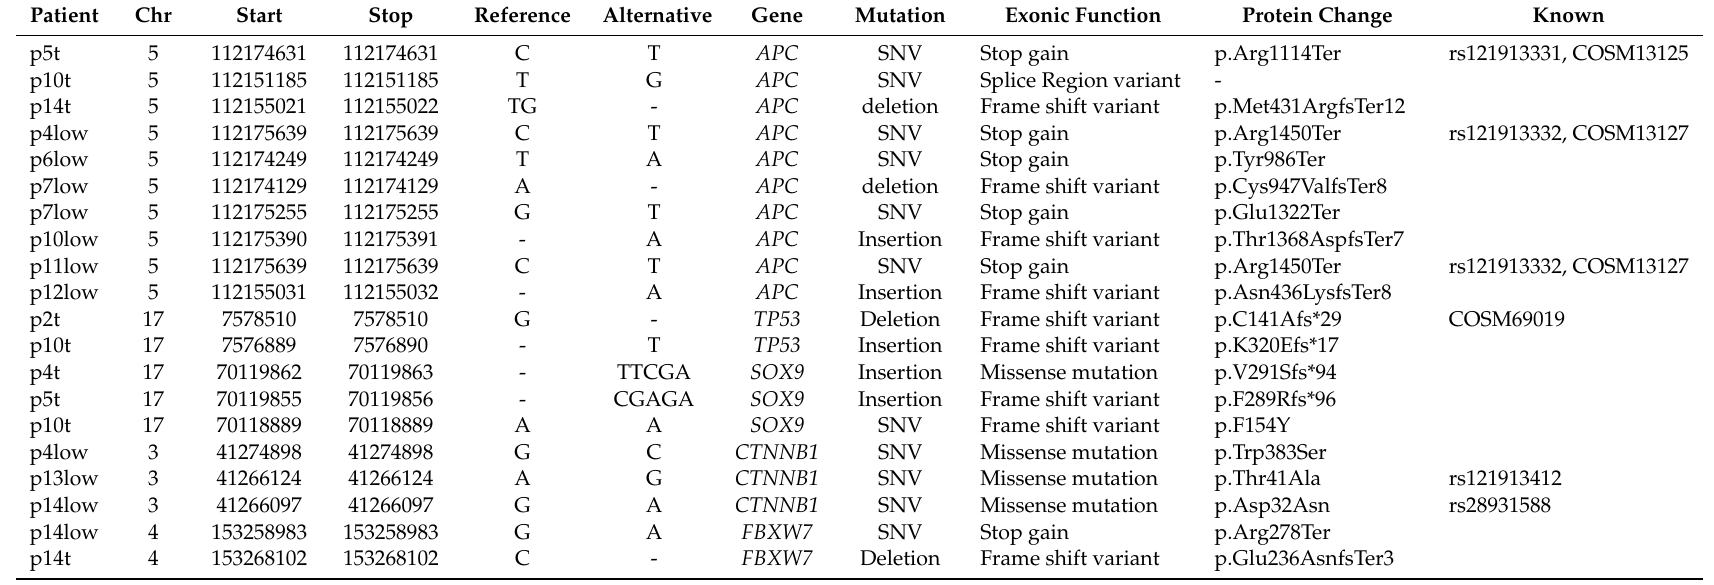
Table 1. Genes with somatic mutations identified in this study that overlap with TCGA, Chinese, and African American CRC patient